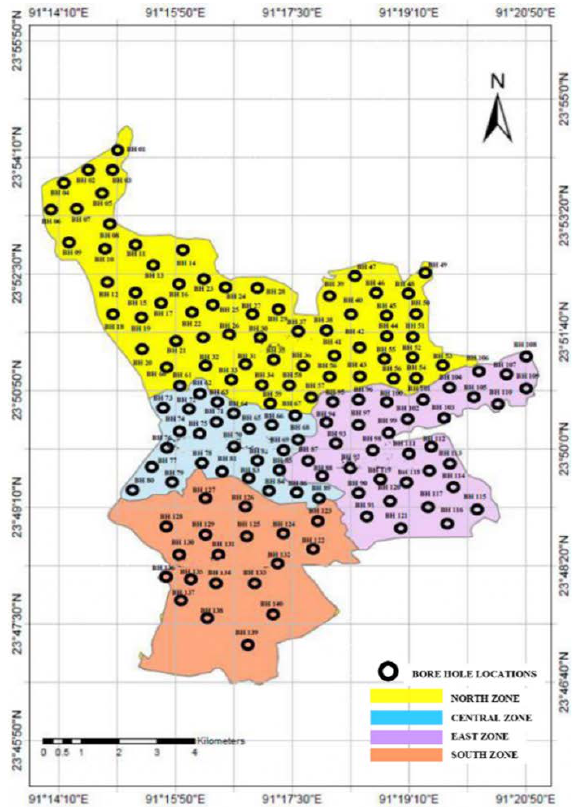
Figure 2. Map of Agartala showing the locations of the 140